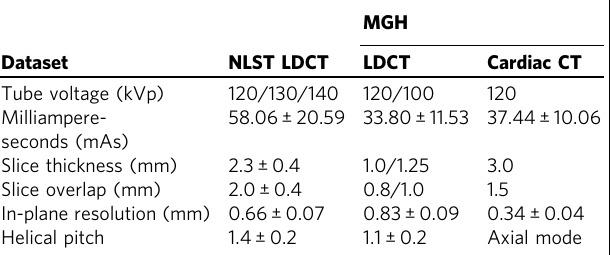
Table 2 CT Scan characteristics of the two independent datasets used in our